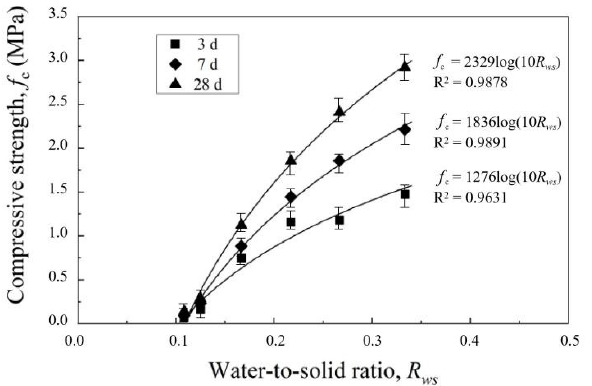
Figure 11. Relationship between compressive strength and water-to-solid ratio ( R ws